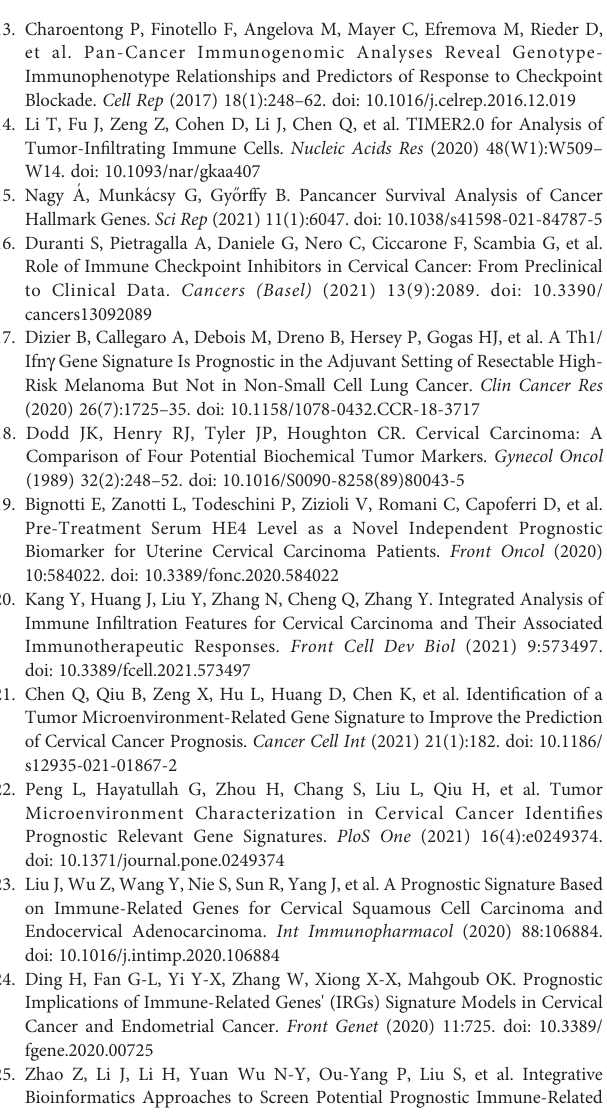
Supplementary Figure 11 | Gene set enrichment analysis identi fi ed hallmark gene sets or immunologic signatures that are activated or suppressed according to their correlation with the four immune-related genes. Supplementary Figure 12 | (A) Scatterplots depicting the negative correlation between GTSF1L expression and clinical biomarkers involving SCC (SERPINB3) and HE4 (WFDC2) in the TCGA-CESC cohort. The Spearman correlation is shown. (B) The Pearson correlation analysis of GTSF1L expression and immune checkpoints, such as BTLA and CD47, in all sorts of cancers of TCGA. Supplementary Figure 13 | High amplication of GTSF1L was linked to higher in fi ltration of CD8 + naive T cell and resting mast cell, but correlated with lower in fi ltration of NK cell and activated mast cell, according to the online tool TIMER 2.0. Supplementary Figure 14 | Spearman correlation analysis of the three immune- related genes (CHIT1, GNG8 and PLA2G2D) and tumor-in fi ltrating cells. Supplementary Figure 15 | Kaplan-Meier curves for patients in the TCGA-CESC cohort strati fi ed by both GTSF1L expression and levels of immune checkpoints, such as PD1, PD-L1, CTLA-4, CD47 and CD38 and BTLA. Log-rank test,